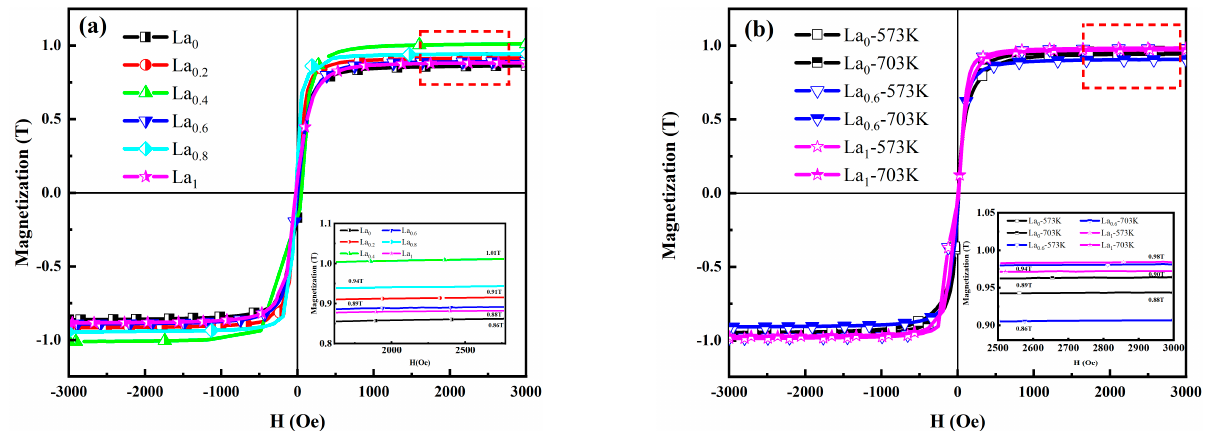
Figure 3. ( a ) The M – H curves of as ‐ spun Fe 27 Co 27 Ni 27 Si 10 − x B 9 La x ( x = 0 to 1) alloys, and ( b ) the M – H curves of Fe 27 Co 27 Ni 27 Si 10 − x B 9 La x ( x = 0, 0.6, 1) alloys after heat treatment at different temperatures for 5